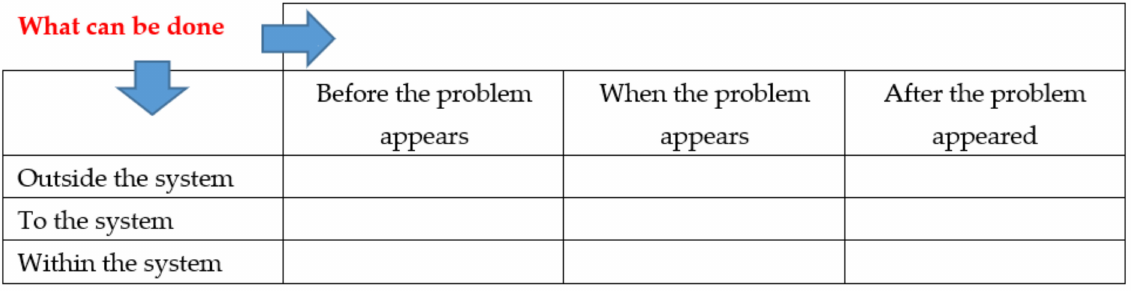
Figure 1. Illustrative representation of the System Operator